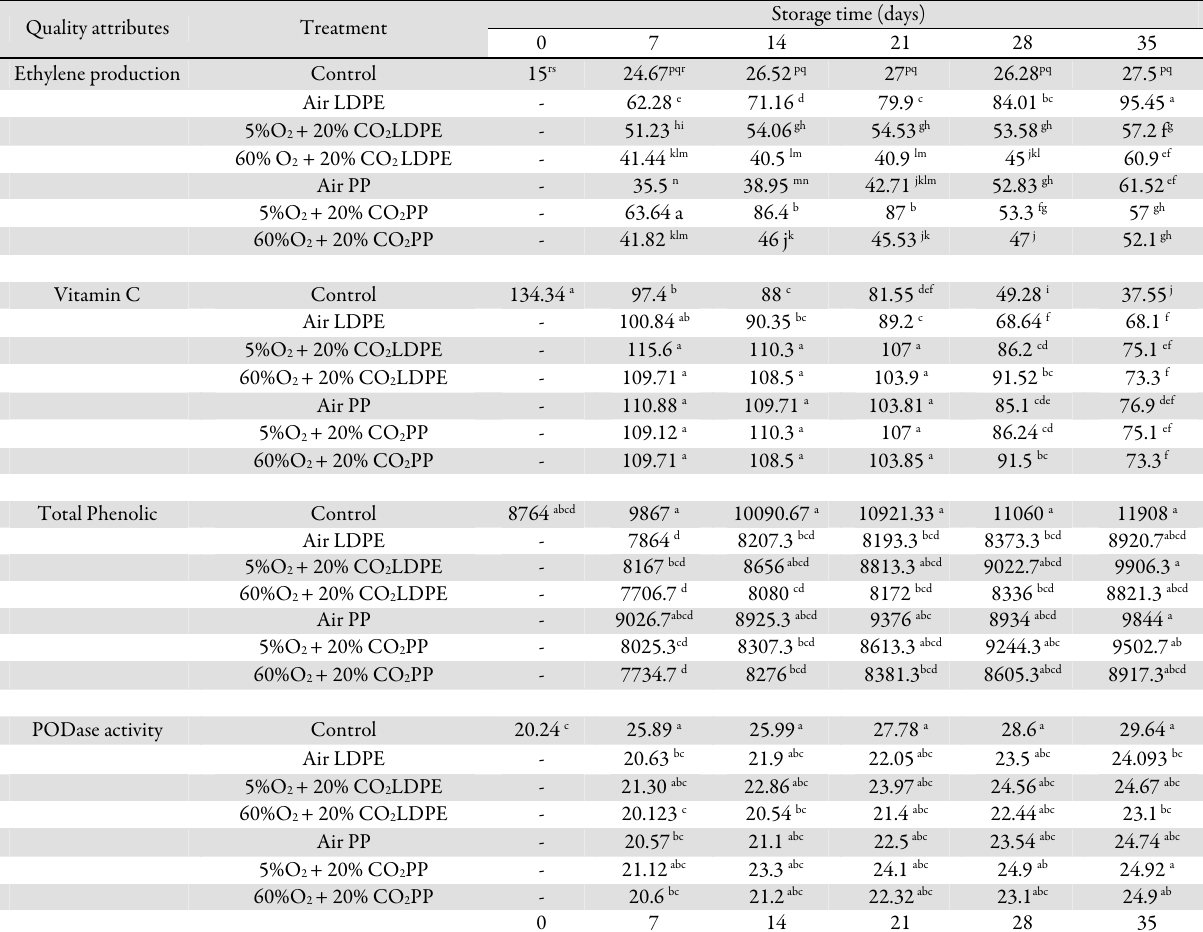
Table 4. Changes in ethylene production, vitamin C, total phenolics and PODase activity of cornelian cherry fruits before (day 0) and after 5 weeks of storage at 1 °C packaged in two types of polymeric films: LDPE- low density polyethylene, PP- polypropylene using three gas combinations: 5%O 2 + 20%CO 2 + 75%N 2 , 60%O 2 + 20%CO 2 + 20%N 2 , and Air compared with control